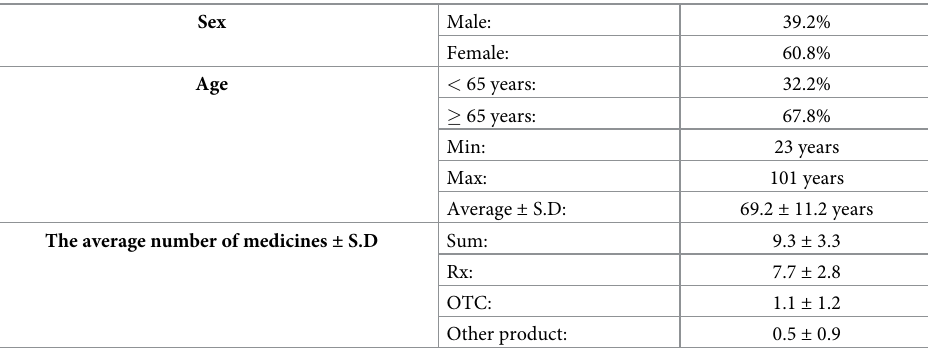
Table 5. Characteristics of patients surveyed.